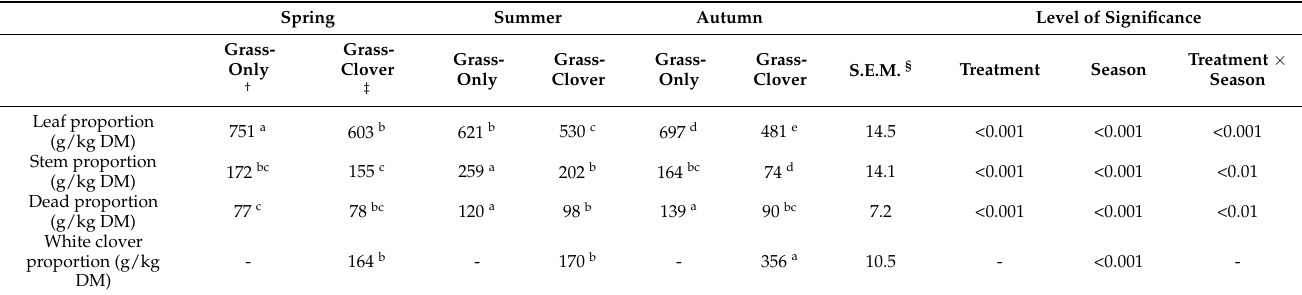
Table 1. Morphology of the forage offered to individually housed sheep in spring (27 March–29 April), summer (19 June–22 July) and autumn (4–29 September) (measured >4 cm). LSMeans for the interaction are